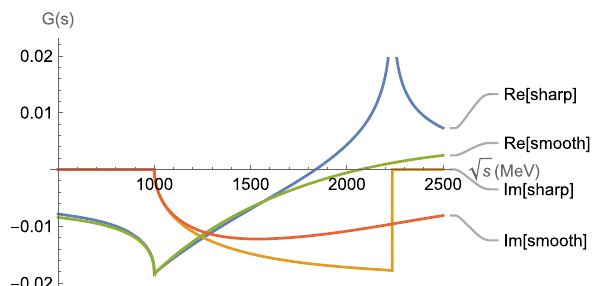
Fig. 2 Loop function with different type of